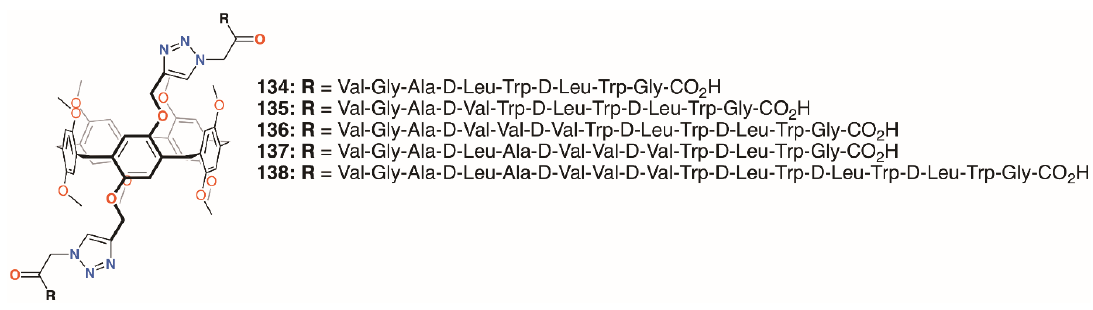
Figure 21. Xin’s pore-forming pillar[5]arenes.